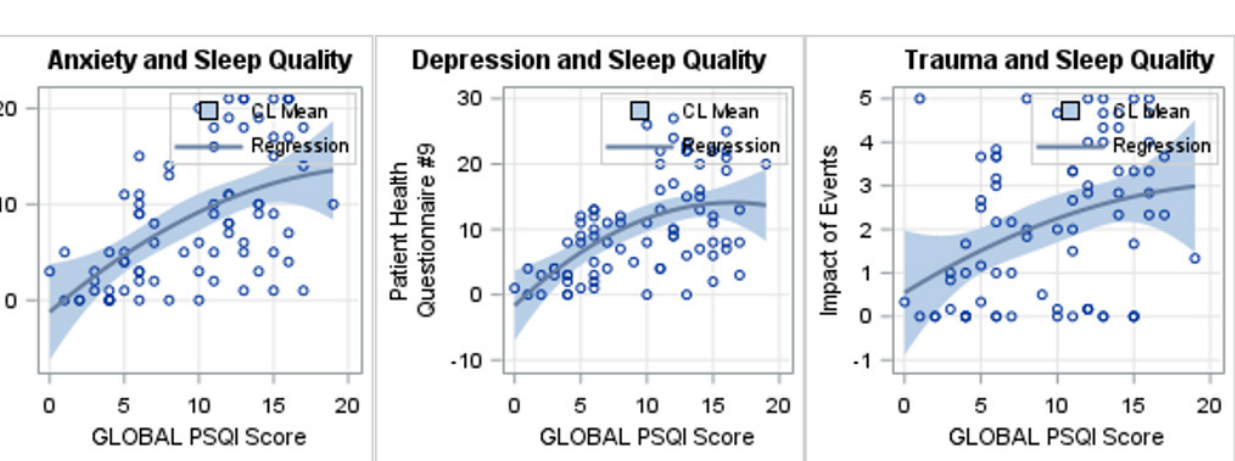
* Indicates significant at alpha 0.05 level. Values are represented as β (SE). β = regression coefficient (represents the slope of the linear relation of the predictor variable and the outcome variable), SE = standard error. Acronyms: PSQI = Pittsburgh Sleep Quality Index.